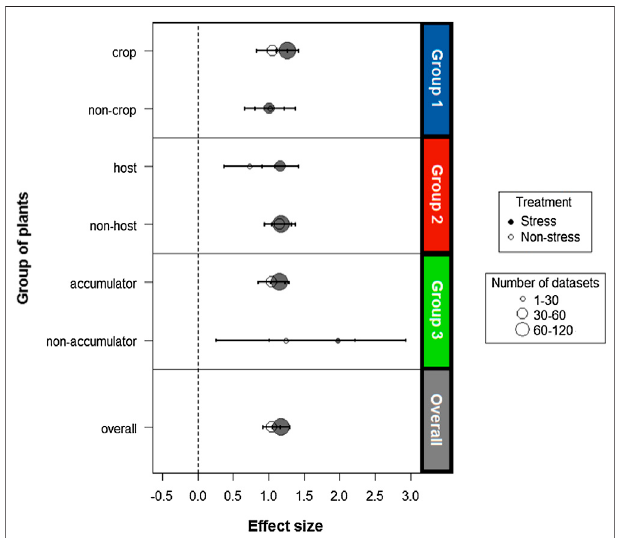
FIGURE 5 | Analysis of the size of the cumulative effect under stress causedbydifferentmetalsinthefunctionalplantgroups.Theopenandclosed symbols present the effect sizes of endophytes on host plants in the absence and presence of stress, respectively. The size of the symbols indicates the number of combined studies to calculate the measurements. The overall summary effect sizes without ( n (cid:1) 54) and with stress ( n (cid:1) 123) are presented in gray. The horizontal error bars represent the ± 95% con fi dence intervals (CIs). Ifthe CIs do not cross thevertical dotted lines ( d (cid:1) 0), the effect size fora combination of a certain functional group is signi fi cant at p <